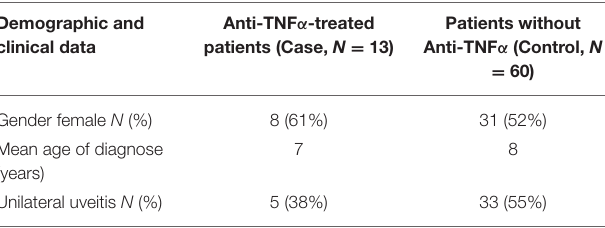
TABLE 1 | Demographic and clinical data for the 13 anti-tumor necrosis factor alpha (TNF α )-treated patients (Case) and the 60 patients without anti-TNF α (control).